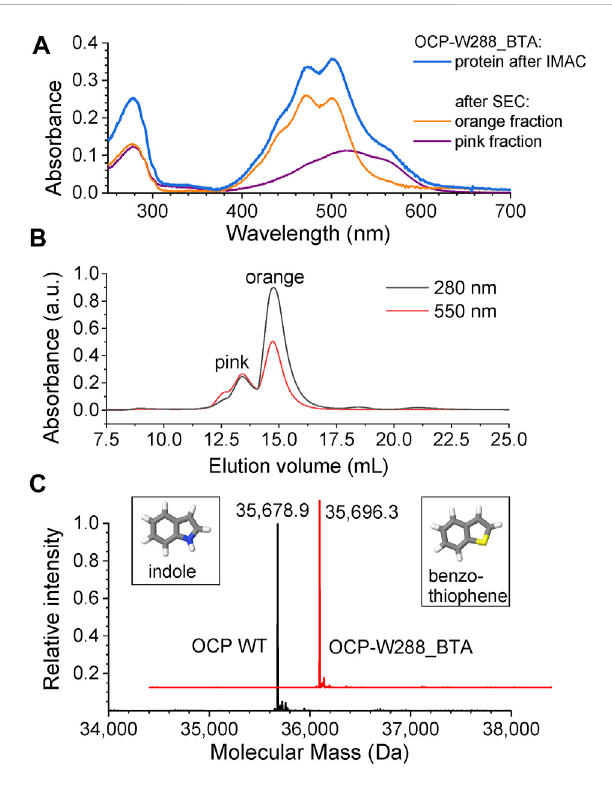
FIGURE 3 Chromatographic separation and mass spectrometric analysis ofOCP-W288_BTAprotein. (A) AbsorbancespectraoftheOCP-W288_BTA sample after His-tag af fi nity elution (immobilized metal af fi nity chromatography, IMAC) (blue) and the orange [OCP-W288_BTA(O)] and pink [OCP-W288_BTA(P)] species after SEC. (B) The orange and pink OCP-W288_BTA samples obtained by SEC. The elution pro fi les were observed at two different wavelengths as indicated. (C) Deconvoluted ESI- MS pro fi les of full-length OCP (wild-type) and OCP-W288_BTA (orange species). The observed molecular masses were: Wild-type